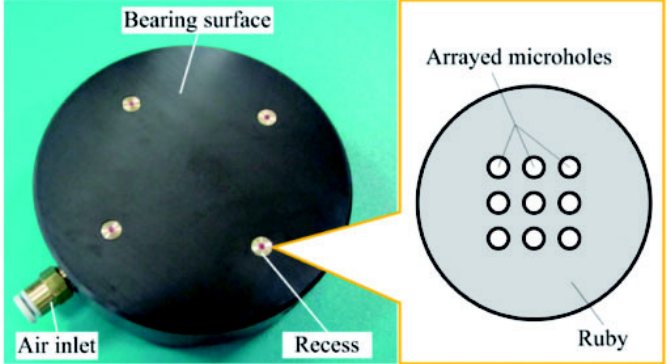
Figure 12. Photo of a recessed aerostatic bearing with AMR [64].